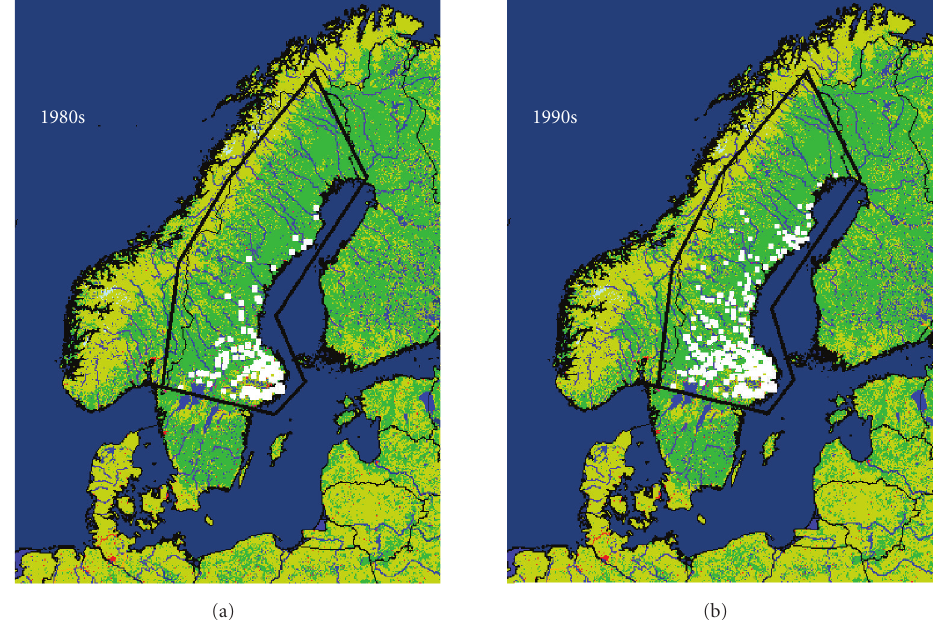
Figure 1: Changes in tick distribution in northern and central Sweden. White dots illustrate districts in Sweden where ticks were reported to be present before 1980 (a) and in 1994-1995 (b). The study region is within the black line (Lindgren et al. 2000, [12] with permission from Environmental Health Perspectives